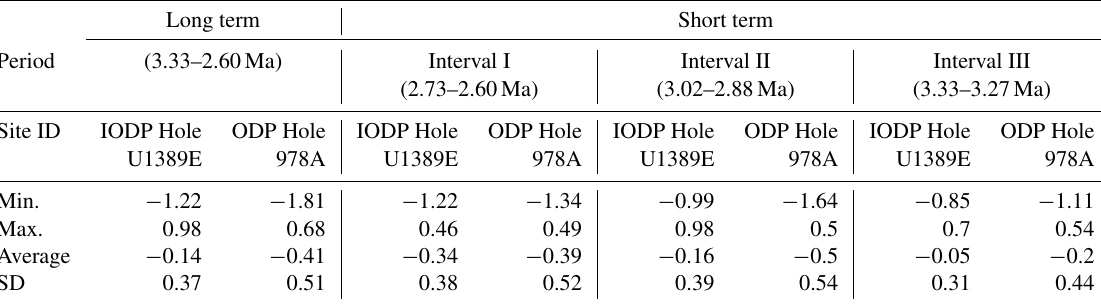
Figure 4. (a) Details of δ 18 O records of IODP Hole U1389E and ODP Hole 978A for intervals I–III. Periods of lowered NADW and increased influx of IRD from DSDP Site 607 (Mid-Atlantic Ridge) reported in Kleiven et al. (2002) are indicated. (b) Calculated δ 18 O gradients between the Gulf of Cádiz and the Alboran Sea for glacial and interglacial stages in intervals I–III (see Supplement, Table S2). Table 2. Minimum, maximum, mean, and standard deviation of δ 18 O values of IODP Hole U1389E and ODP Hole 978A in the long term and within intervals I, II, and